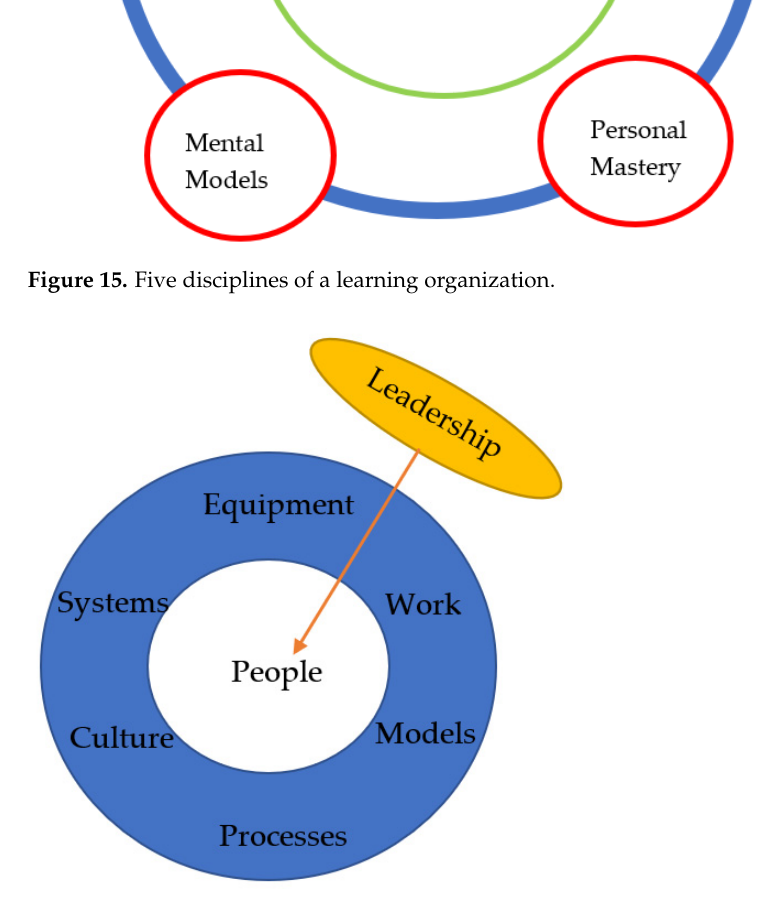
Figure 16. The relationship between the leadership in an organization and the people.